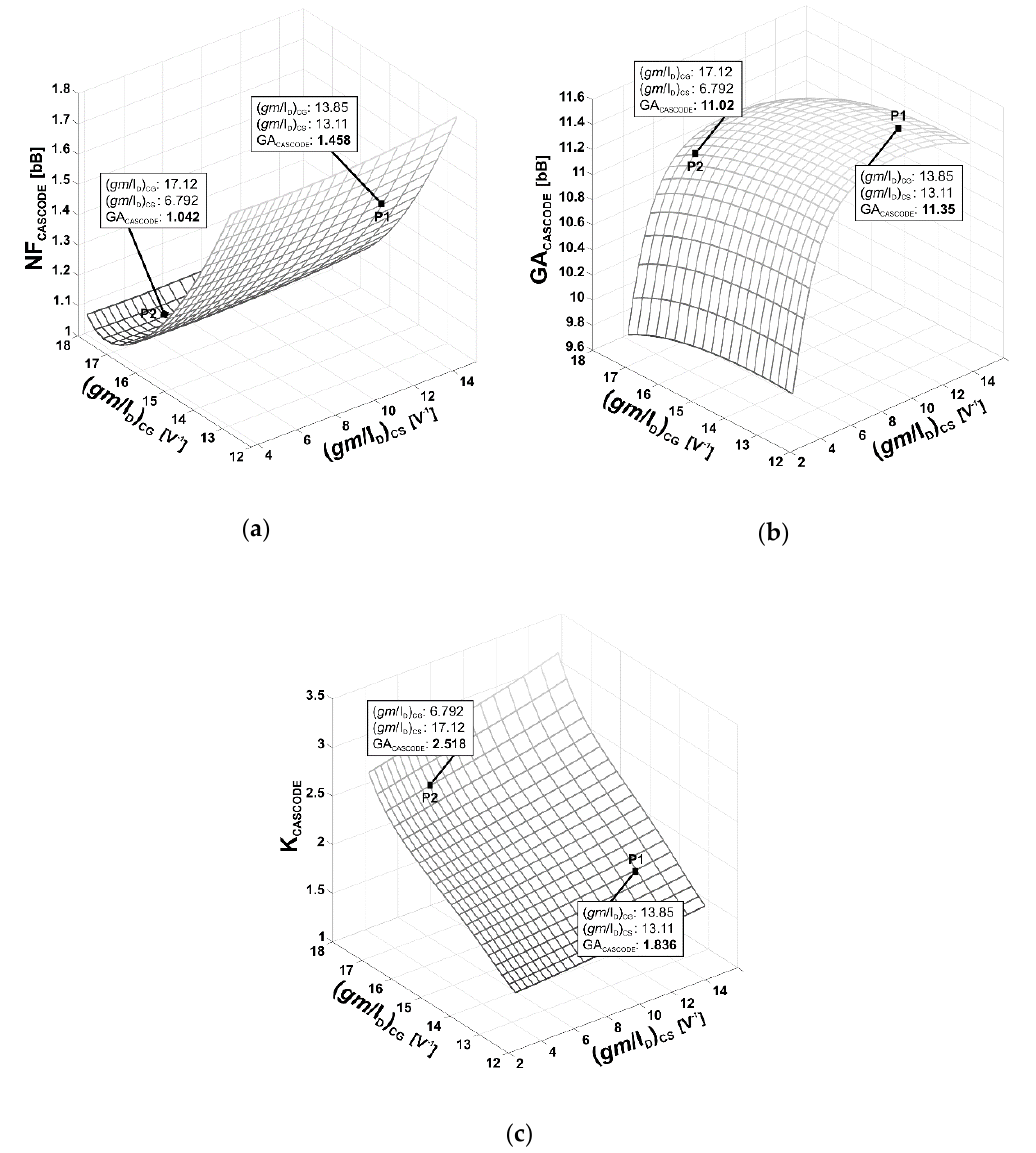
Figure 14. Plot of the cascode stage response for the minimum noise figure, as a function of the ( gm / I D ) CS and ( gm / I D ) CG : ( a ) noise figure; ( b ) gain; ( c ) stability factor K